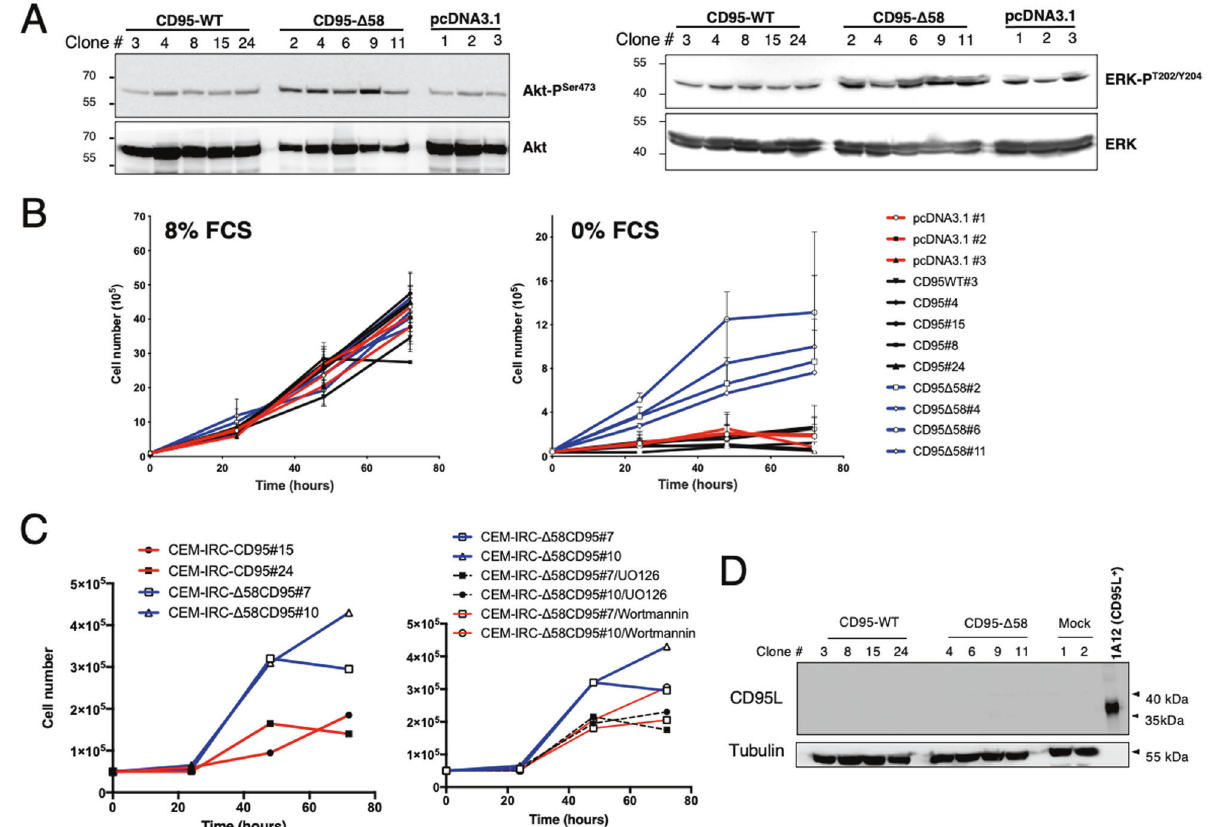
Fig. 6 Elimination of the CD95 amino terminal region enhances pro-survival signaling pathways in a CD95L-independent manner. A Serum starved CEM-IRC cells reconstituted with full-length CD95, CD95- Δ 58 or empty vector were lyzed and the indicated immunoblots were performed. Activation status of the PI3K and MAPK kinase pathways was evaluated by phosphorylation of Akt at Ser473 and ERK at T202/ Y204, respectively. Data are representative of three independent experiments. B Growth curves for full-length CD95, CD95- Δ 58 or empty vector transfected CEM-IRC clones. Cells (10 4 ) were plated onto 6-well tissue culture dishes and incubated in RPMI containing 8% or 0% FCS. Cells were counted at 0, 1, 2, and 3 days. C Indicated cells were incubated with non-cytotoxic concentrations of the PI3K (wortmannin) and ERK (UO126) inhibitors. Data are representative of three independent experiments. D Western blot analysis of total cell lysates from CEM-IRC cells reconstituted with full-length CD95 (CD95), CD95- Δ 58 or empty vector (numbering indicates clones). Human CD95L-expressing 1A12 cells serve as positive control. Tubulin is used as a loading control. Note: 1A12 is a mouse T-cell line and the anti-tubulin antibody was speci fi c for human tubulin, therefore mouse tubulin was not recognized in 1A12